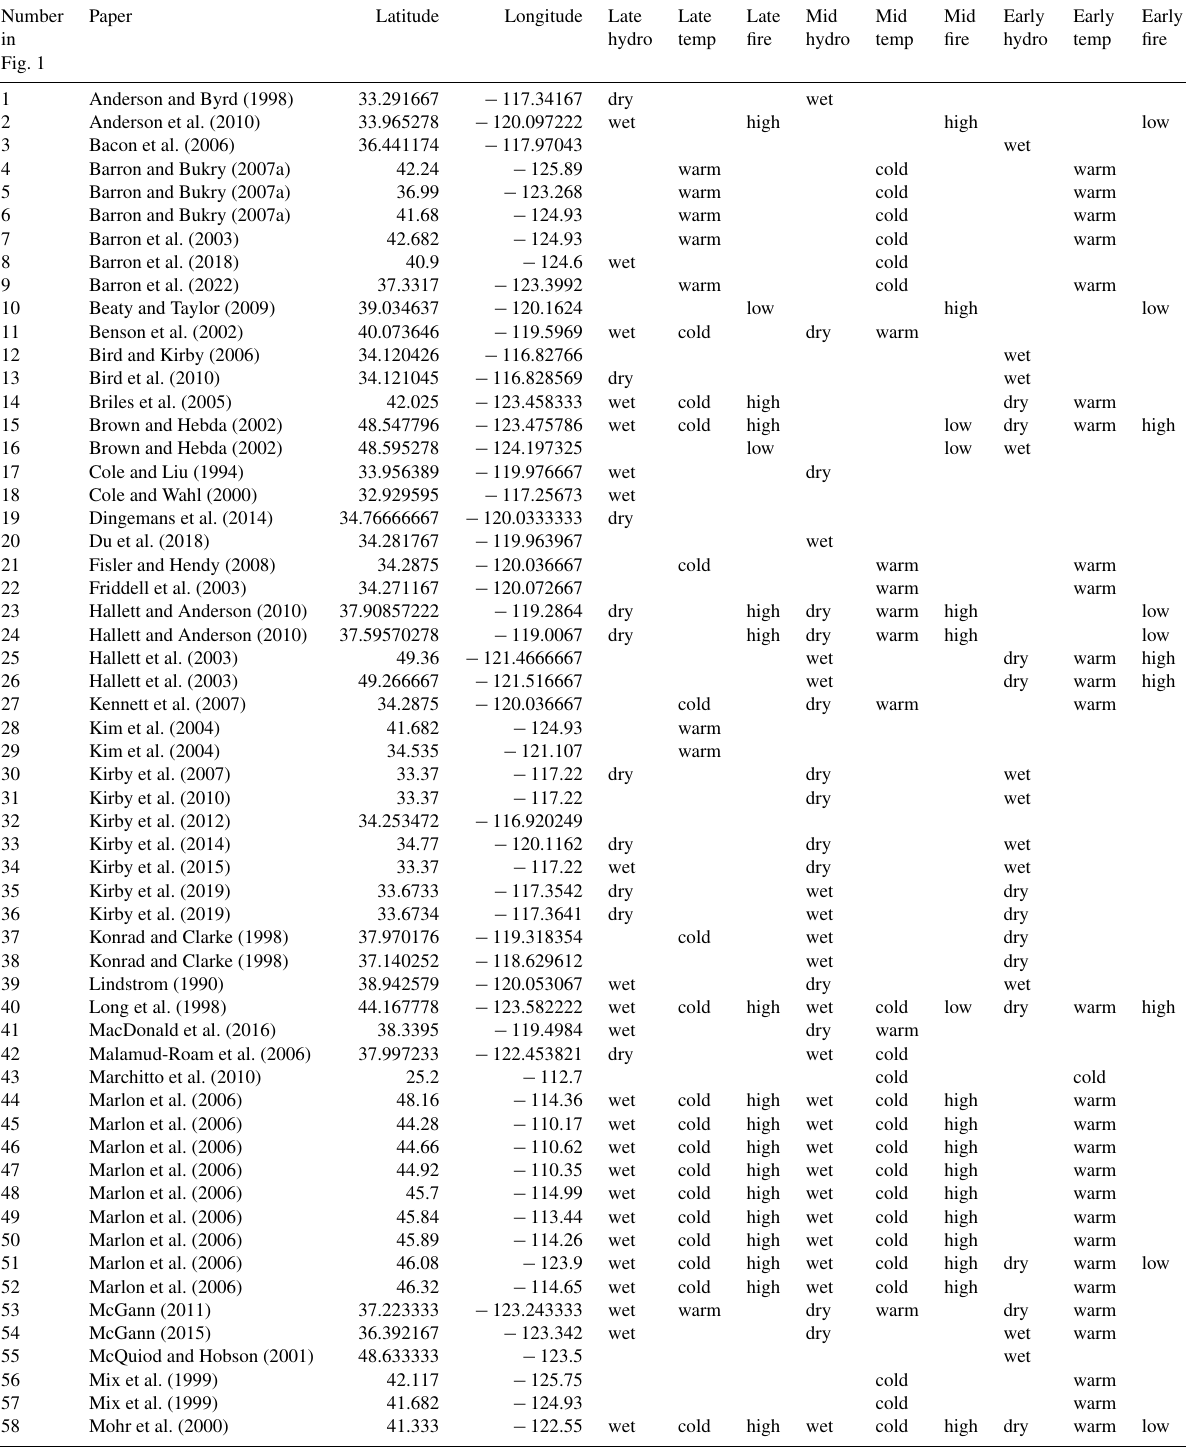
Table A1. Appendix A shows the results of the coded spatiotempo- ral analysis of previously published